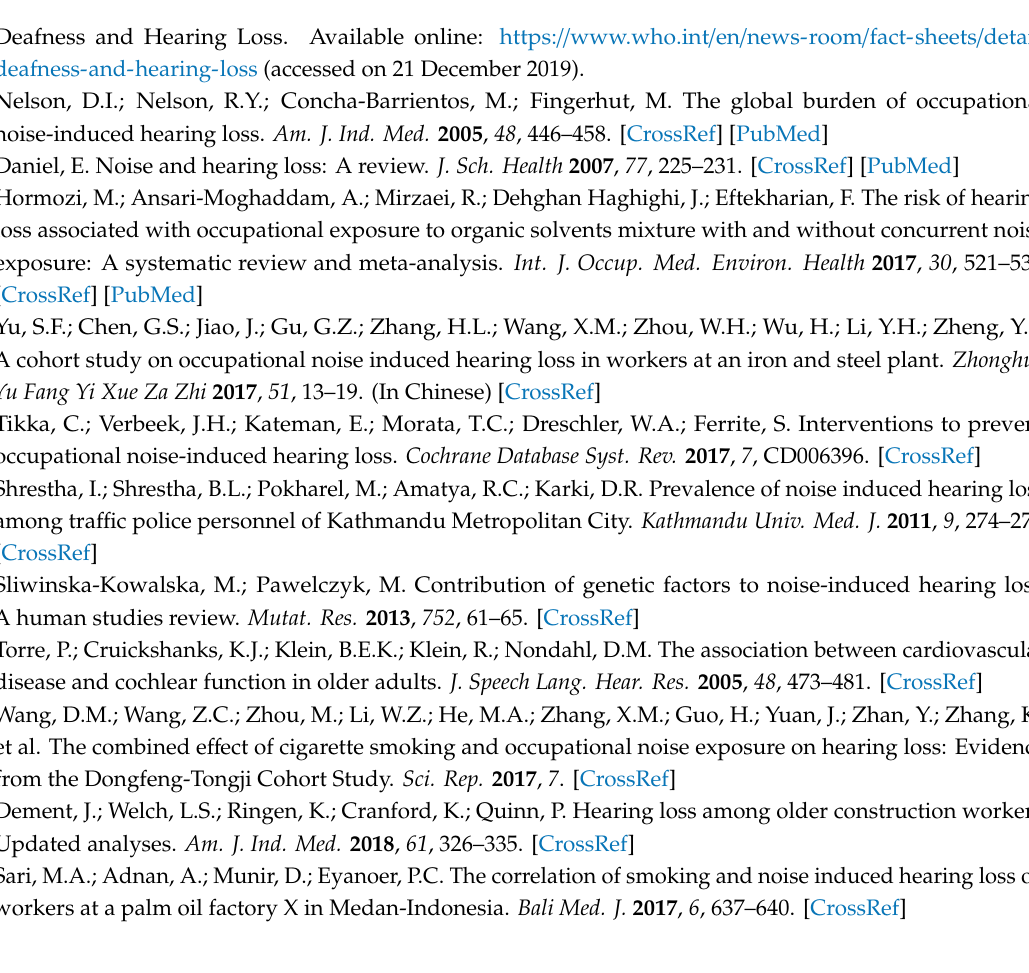
Figure S1: Forest plot for the association between former smokers and NIHL risk, Figure S2: Sensitivity analysis of former smokers and NIHL, Figure S3: Funnel plot of current smokers and